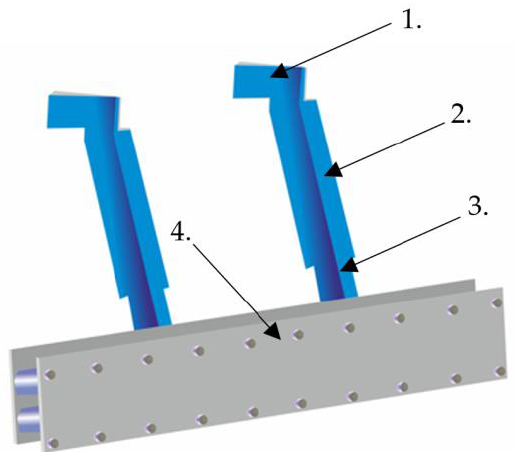
Figure 6. RUPD provided with impact energy-absorbing elements. 1 — Support member fixed to the intermediate frame; 2 — Support length adjustment mechanism; 3 — Support member fixed to the the intermediate frame; 2—Support length adjustment mechanism; 3—Support member fixed to the RUPD guard bar; 4 — RUPD guard bar with energy-absorbing elements. RUPD guard bar; 4—RUPD guard bar with energy-absorbing